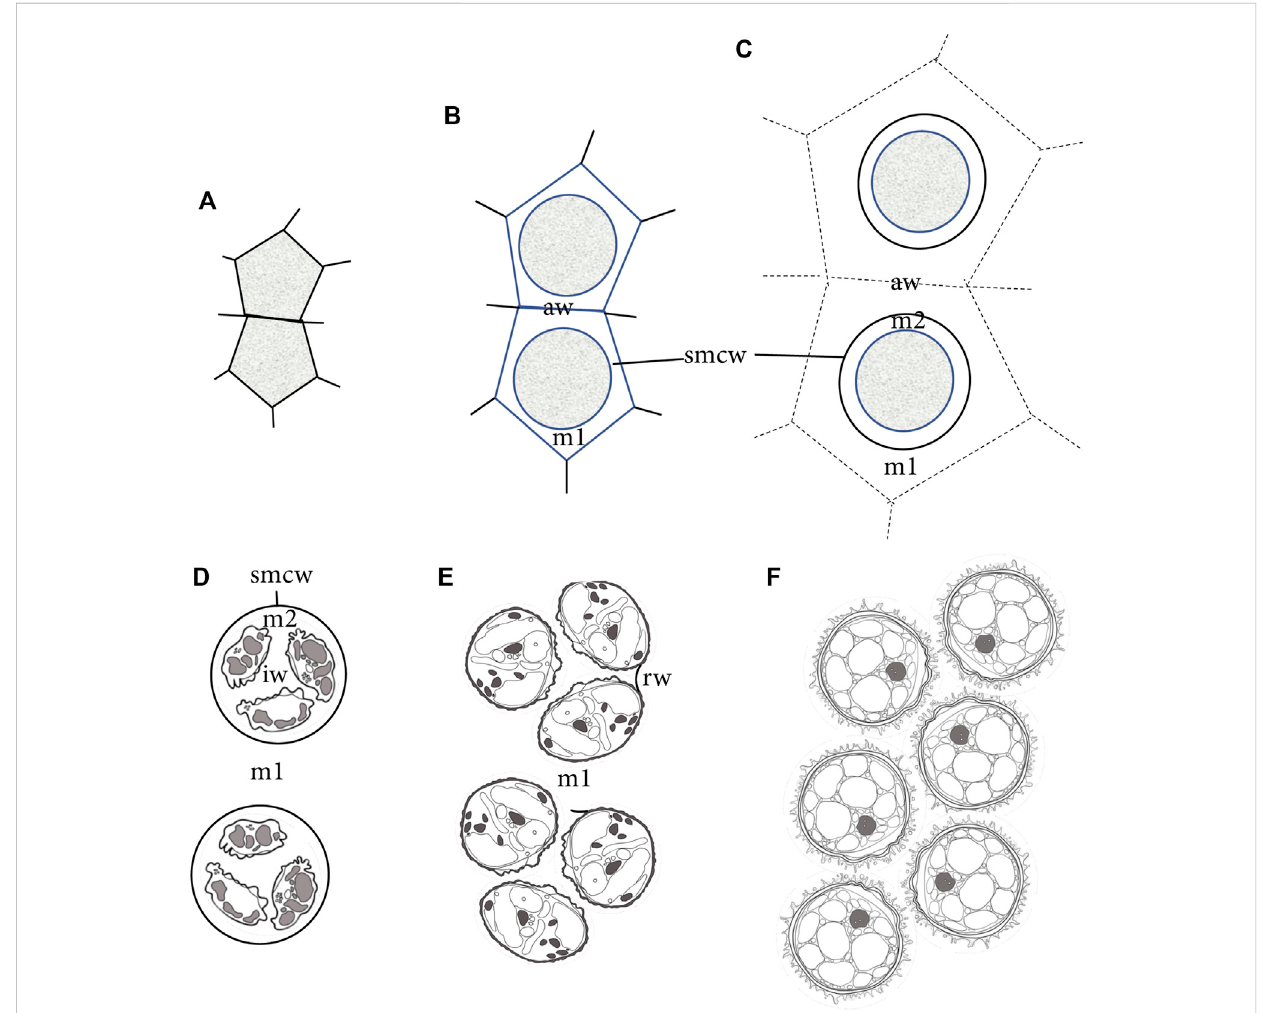
FIGURE 7 Diagrammatic representation of sporogenesis in Physcomitrium patens, illustrating the sequence of development of wall/matrices relative to the sizesofSMCs andspores. (A) Twonewlyformedangular SMCssurroundedbyarchesporialcellwalls. (B) Deposition ofmatrix(m1)materialfromtheSMC rounds the protoplasm and separates SMCs from archesporial cell walls (aw). A thin cell wall (smcw) is deposited around the SMCs. (C) SMCs deposit an extraprotoplasmic matrix (m2) between the thin SMC wall (smcw) and protoplasm. Further deposition from tapetal cells adds to the locular matrix (m1), increasing the distance between SMCs and obscuring archesporial cell walls (aw). (D) Nascent tetrads are suspended in the locular matrix (m1), and each contains four small spores separated by a newly made intersporal wall/matrix (iw), embedded in the extraprotoplasmic matrix (m2) and surrounded by an SMC wall (smcw). (E) Rounded free spores are embedded in the locular matrix (m1) and have expanded beyond the SMC wall, leaving random remnantwallconnections(rw)betweenthesistersporesinatetrad.Aperturesarevisiblealongproximalsurfaceswheresporesintetradsfaceeachother. (F) Expanded mature spores fi ll the capsule